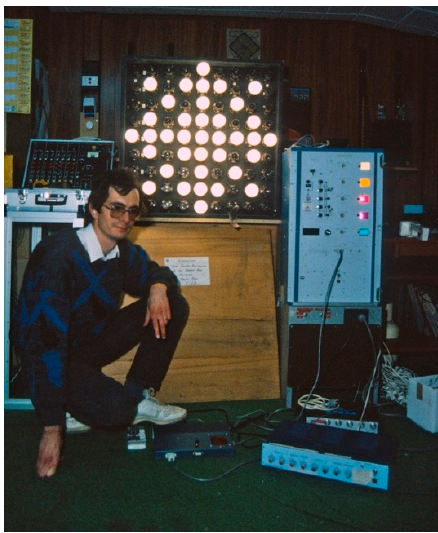
Figure 9. Russell Dahms with the Christmas star prototype in Ostoja’s studio. Published with permission. Image courtesy Russell Dahms. Arts 2019 , 8 , x FOR PEER REVIEW